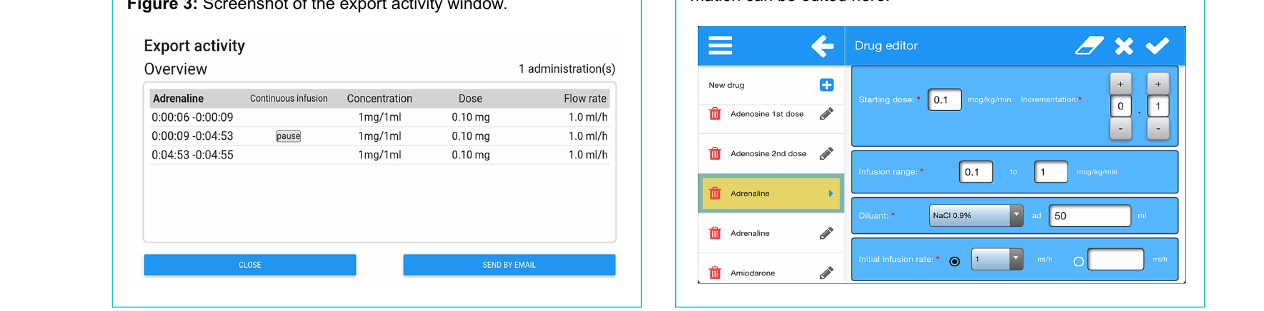
Figure 4: Screenshot of the drug editor. All drug-related infor- mation can be edited